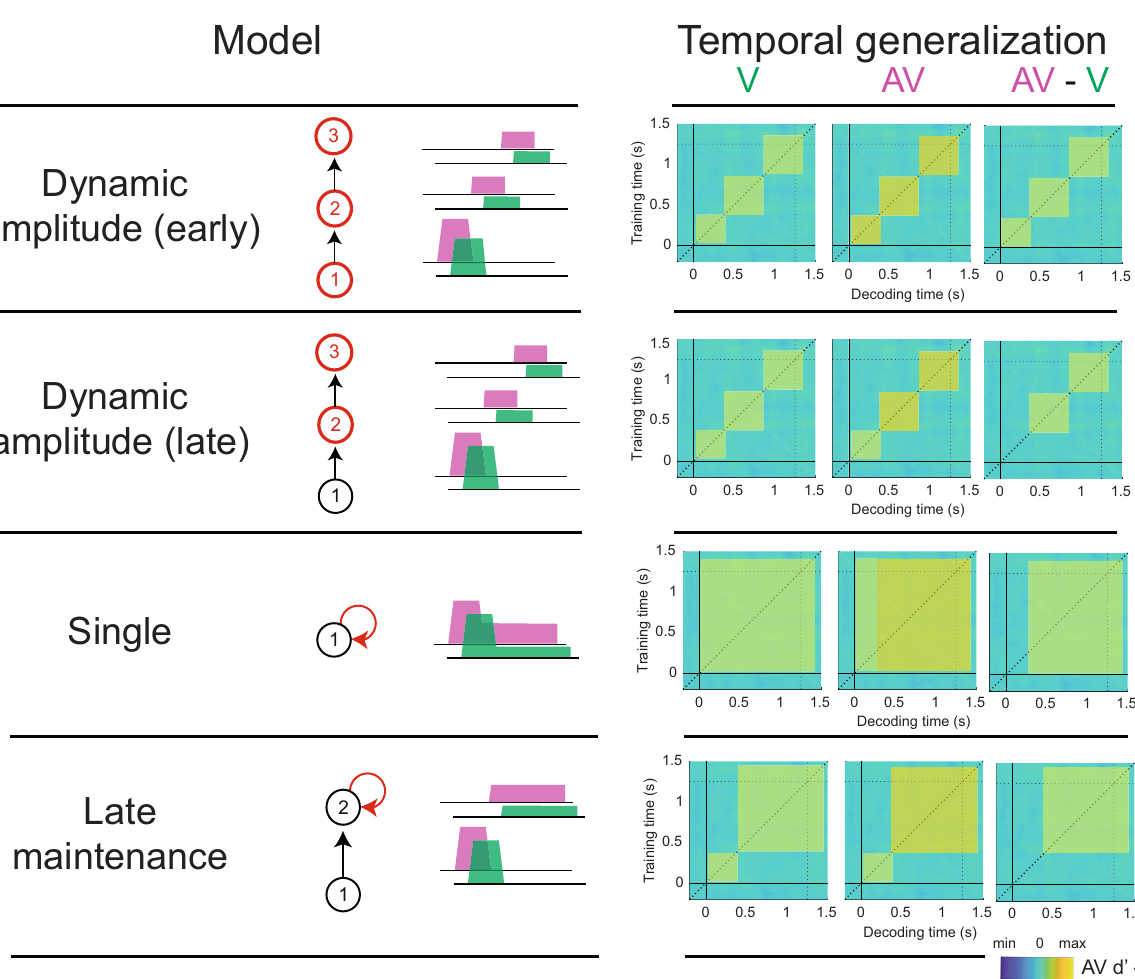
Fig. 10 Candidate dynamical processing models beyond the sound-induced visual detection enhancement. Sounds might improve the detectability of a visual signal through different mechanisms. To characterize the dynamic nature of information processing we describe four models that vary in terms of the number and ordering of processing stages. We propose that sounds could enhance detection by increasing (1) the decoding amplitude or (2) the duration of one or several processing stages: The dynamic amplitude models broadcast target information across a sequence of short-lived processing stages whose amplitude codes for its detectability. We hypothesize that sounds might act upon one of these stages, boosting the decoding amplitude at early or late processing stages. The single stage model encodes and maintains the target information within the same processing stage. We propose that sounds might improve the maintenance of information within the initial processing stage. The late maintenance model transmits the encoded information to a later processing stage where task-relevant information is sustained through recurrent processing loops. Sounds might enhance the maintenance of information within the later processing stage. Vertical arrows represent information transfer from one neural stage to the next. Circular arrows represent recurrent feedback loops that maintain information over time. The key process that characterizes the effect of sounds in each model is highlighted in